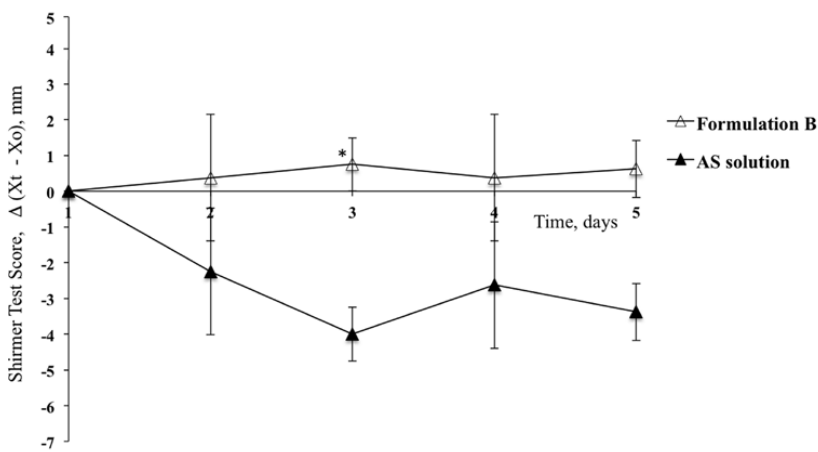
Figure 5. Shirmer Test Scores for the group of rabbits treated with Formulation B and for contralateral eyes (Reference) after treatment with AS solution. (Means ± SE, n = 6). * Statistically significant different from the STS calculated for the contralateral eye ( p < 0.05, t -test).